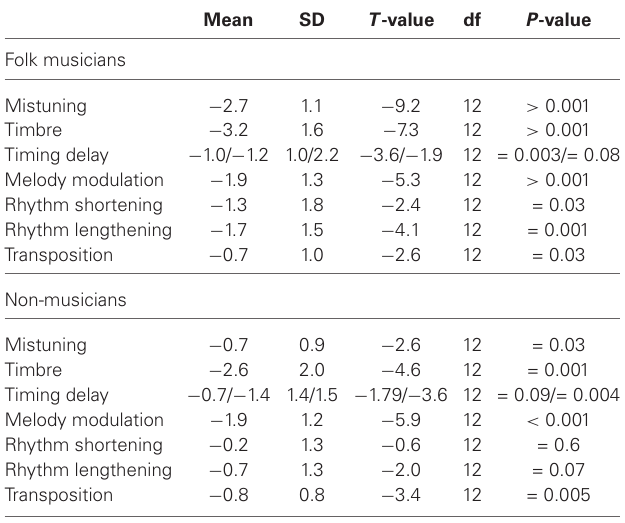
Table 2 | Two-tailed t -tests for verifying the significance of the MMN amplitudes against the zero baseline . Mean SD T -value df